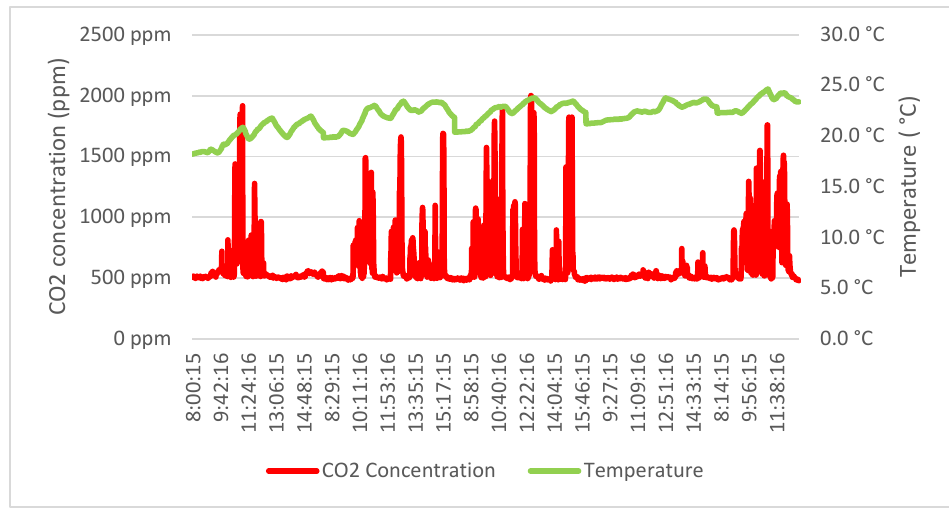
Figure 28. Temperature and CO 2 concentrations in D2 over the four days study week.